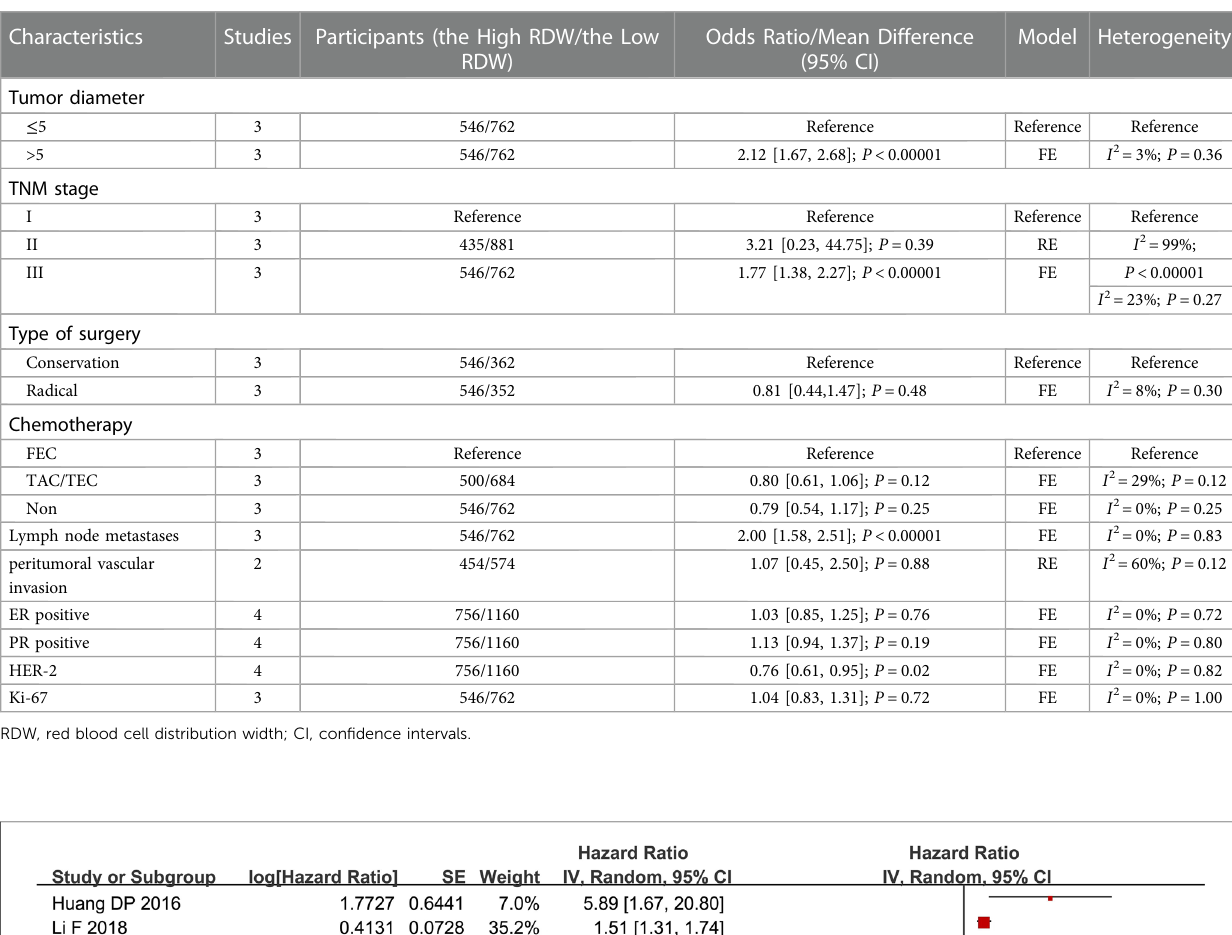
TABLE 2 Summary of characteristics between the high RDW group and the Low RDW group.